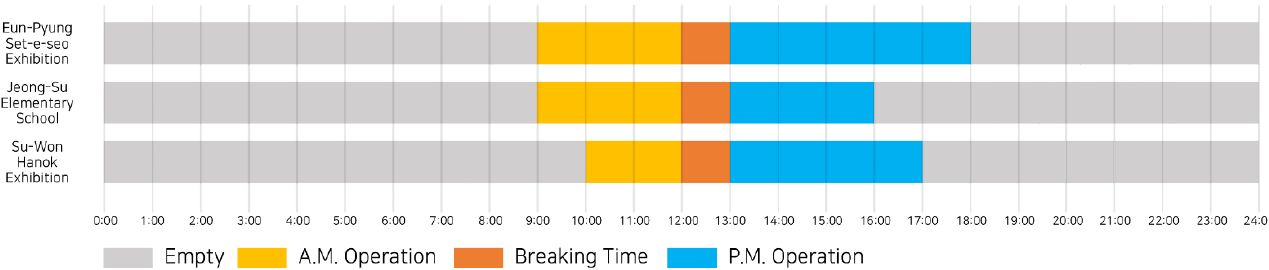
Table 4. Plans and measurement scheme of final target Hanoks.